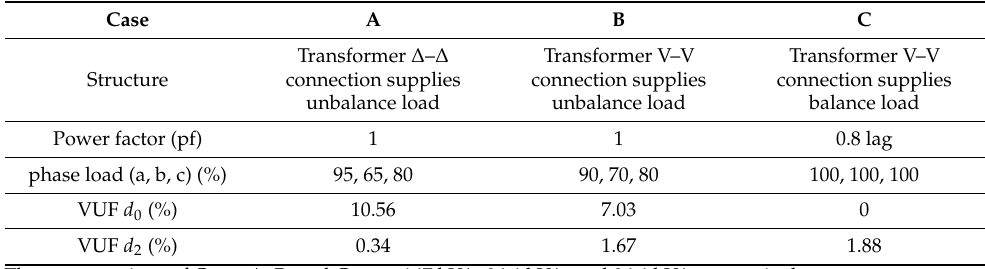
Table 1. Loads of three single-phase currents for severe voltage unbalance